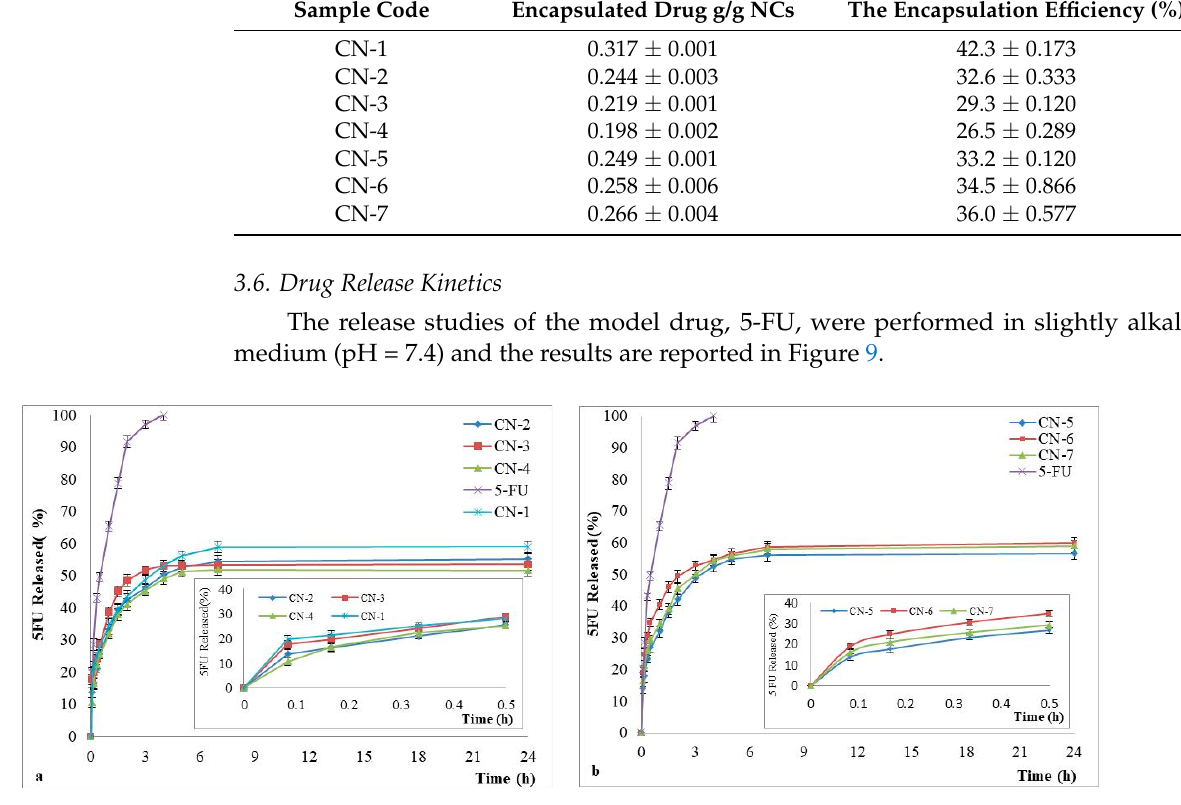
Figure 9. In vitro release kinetics of 5-FU from NCs in phosphate buffer solution (pH 7.4), with a zoom insert of the release kinetics between 0 and 30 min, for samples ( a ) CN-2, CN-3, and CN-4; ( b ) CN-5, CNM-6, and CN-7.